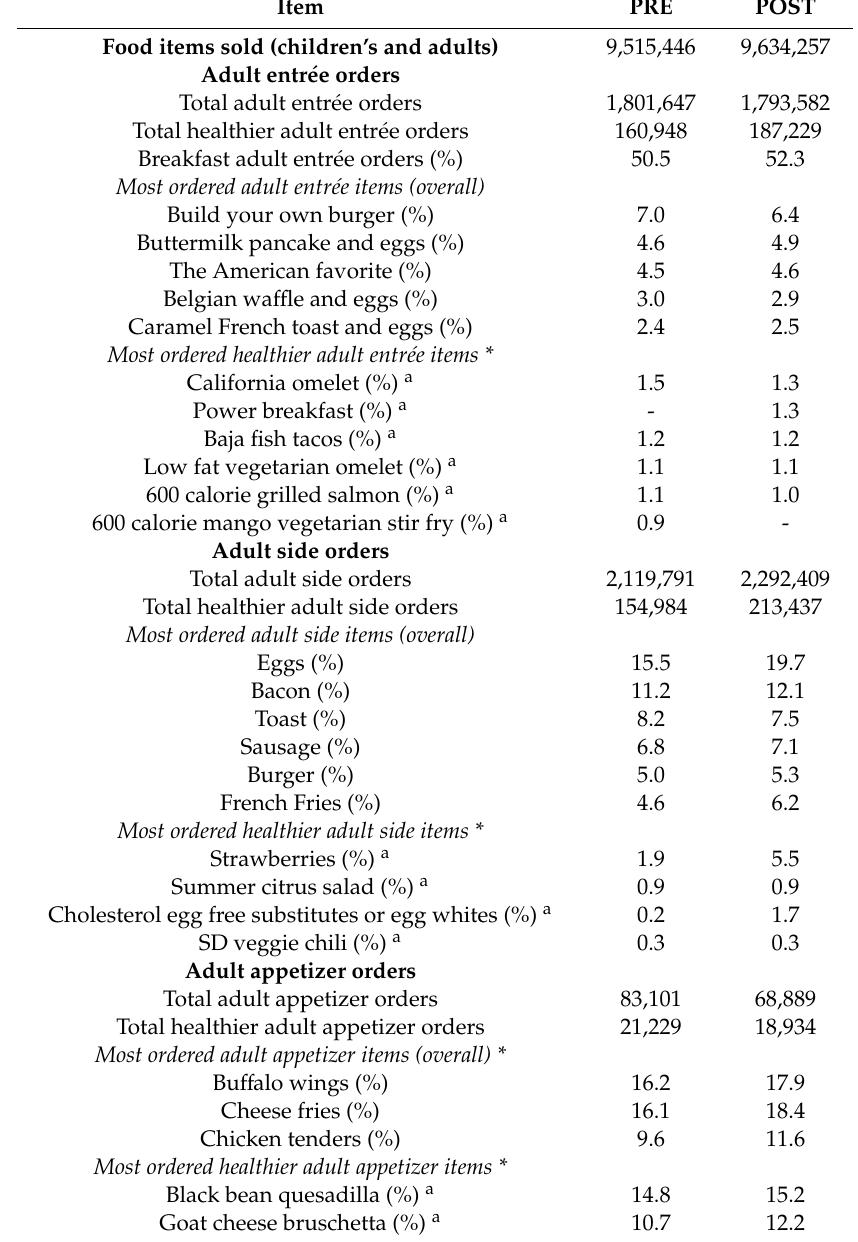
Table 3. Adult menu items ordered before (PRE) and after (POST) the implementation of a healthier children’s